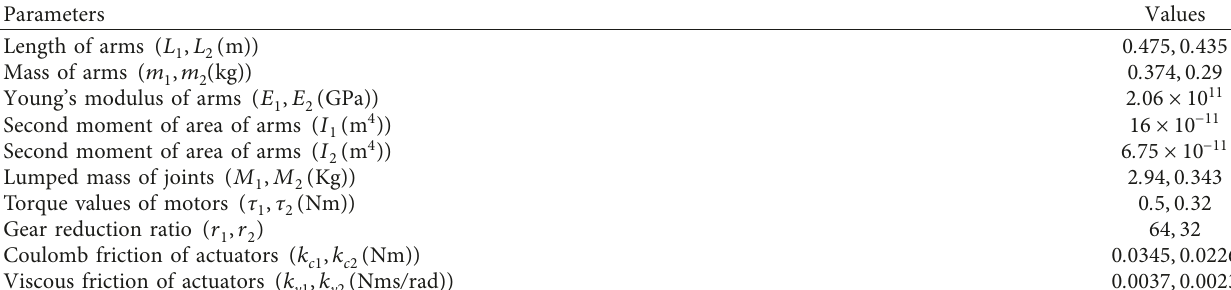
Table 2: Parameters of components in the experimental